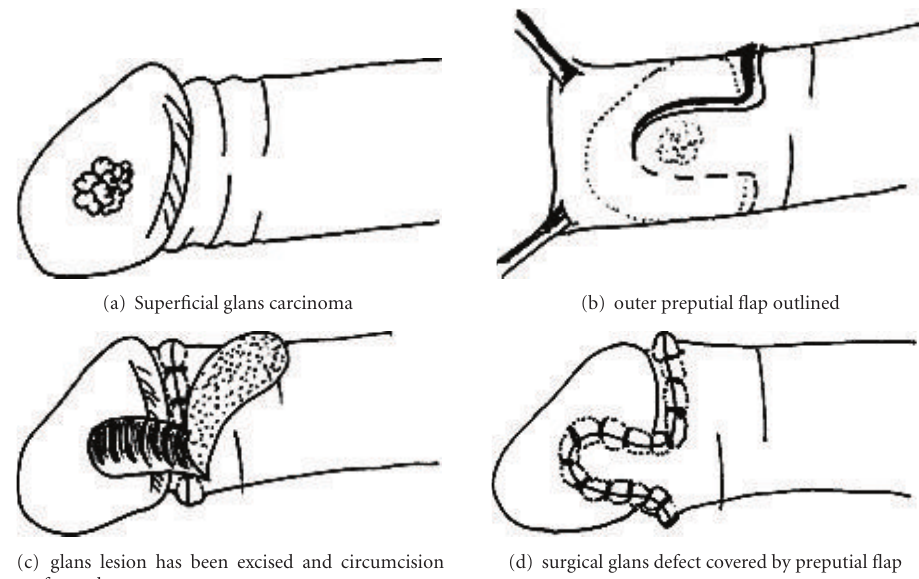
Figure 1: Outer preputial full-thickness skin flap as described by Ubrig et al. (2001) to cover surgical glans